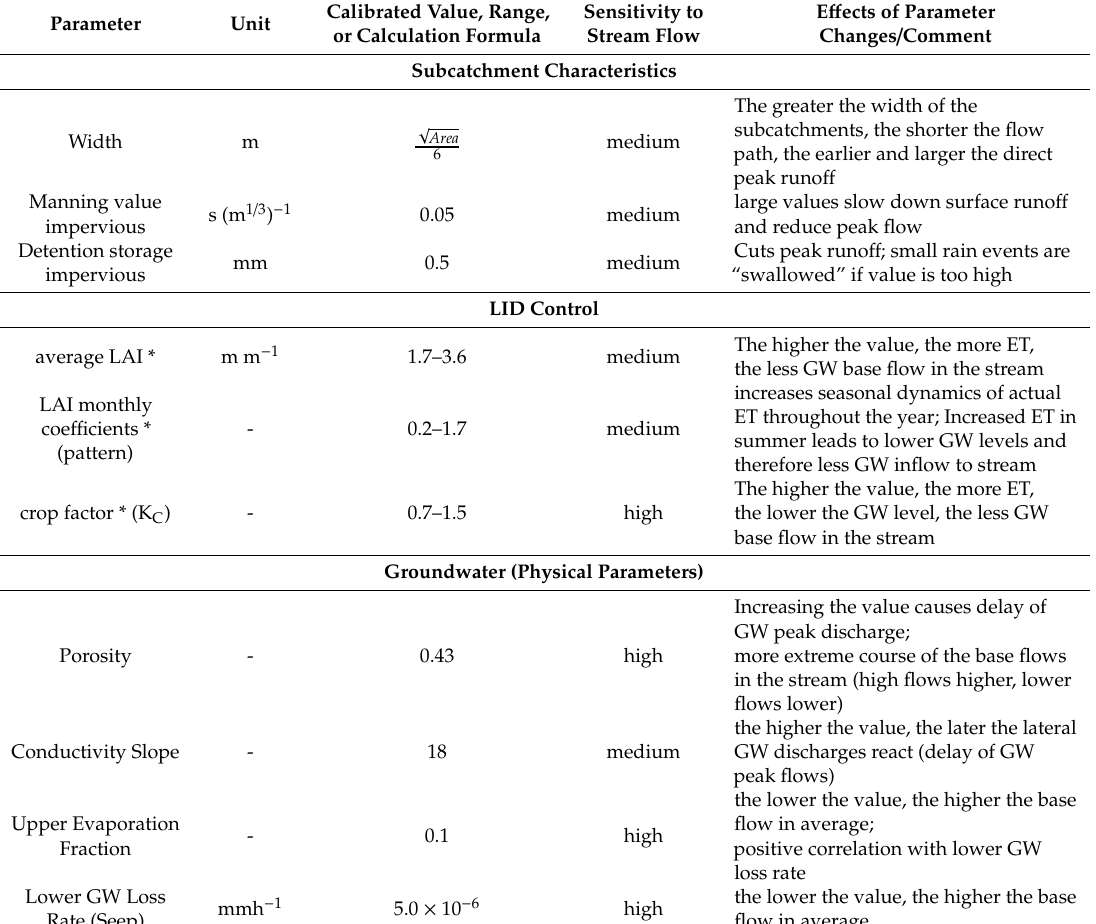
Table 4. Parameter sensitivities and e ff ects of parameter changes regarding stream flow (* only